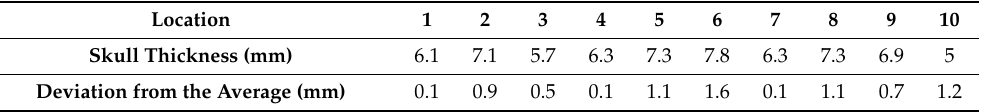
Figure 8. Locations of the samples numbered 1–10 and highlighted in grey. Measurements were carried to find the closest thickness between the numerical model and the samples. Table 3. Model thickness measurements in di ff erent skull locations.